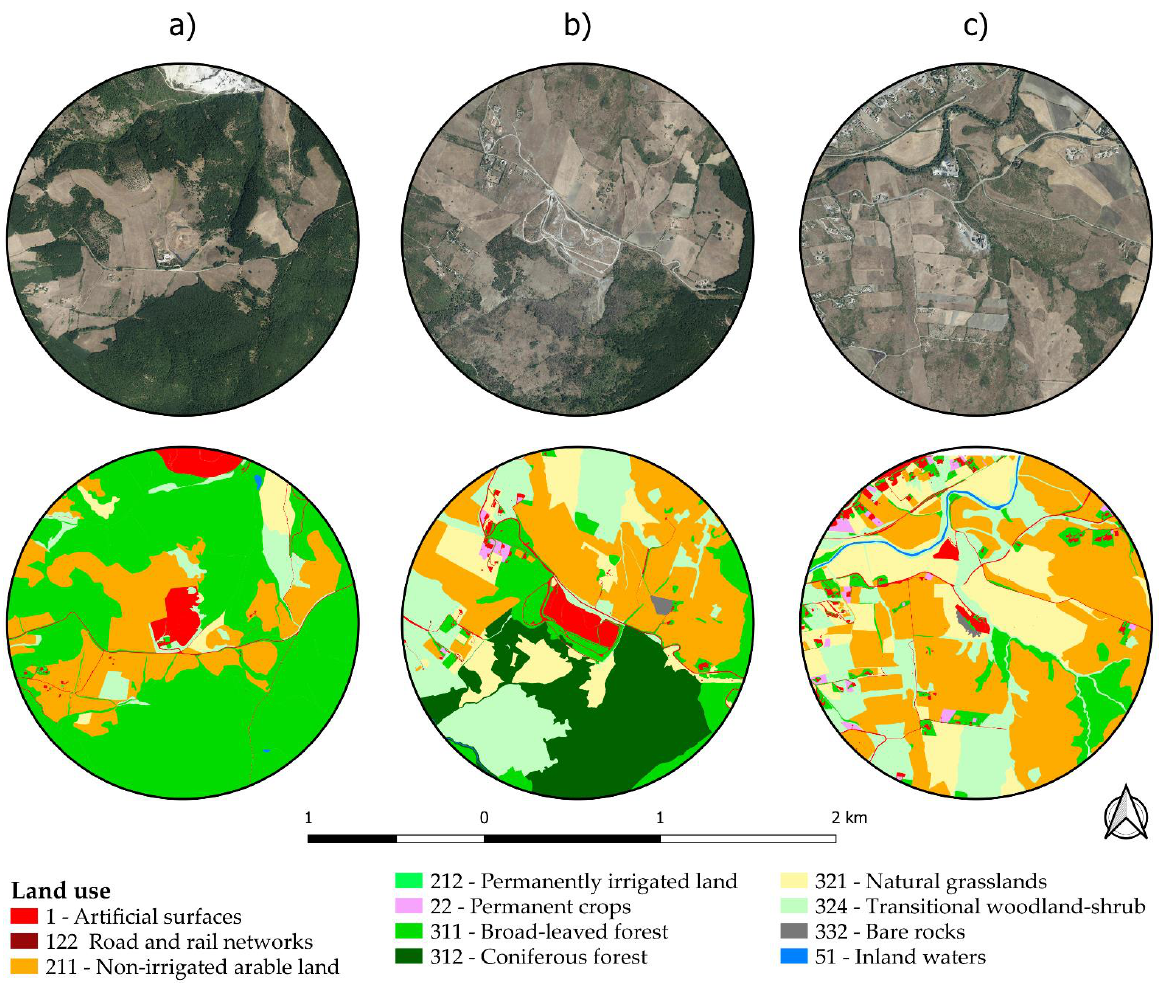
Figure 2. Orthophoto and land use map of study areas: ( a ) Aia dei Monaci, ( b ) Montegrosso-Pallareta, ( c ) Vallone Calabrese. Table 1. Land use class distribution in the three study sites.